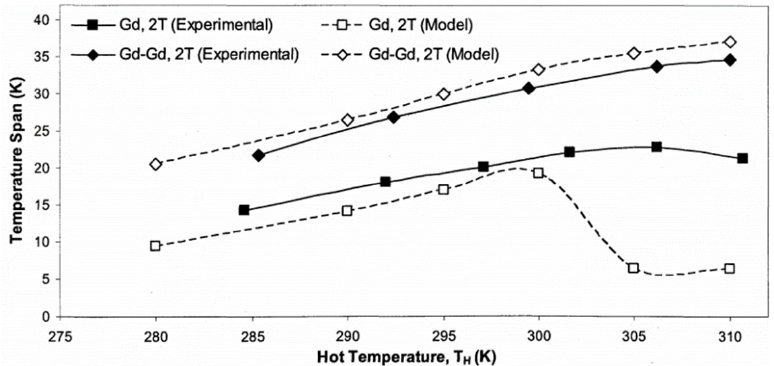
Figure 14. Temperature evolution of tow MCM versus hot temperature under a magnetic field of 2 T. Validation of the model reliability by comparison with experimental results [54].